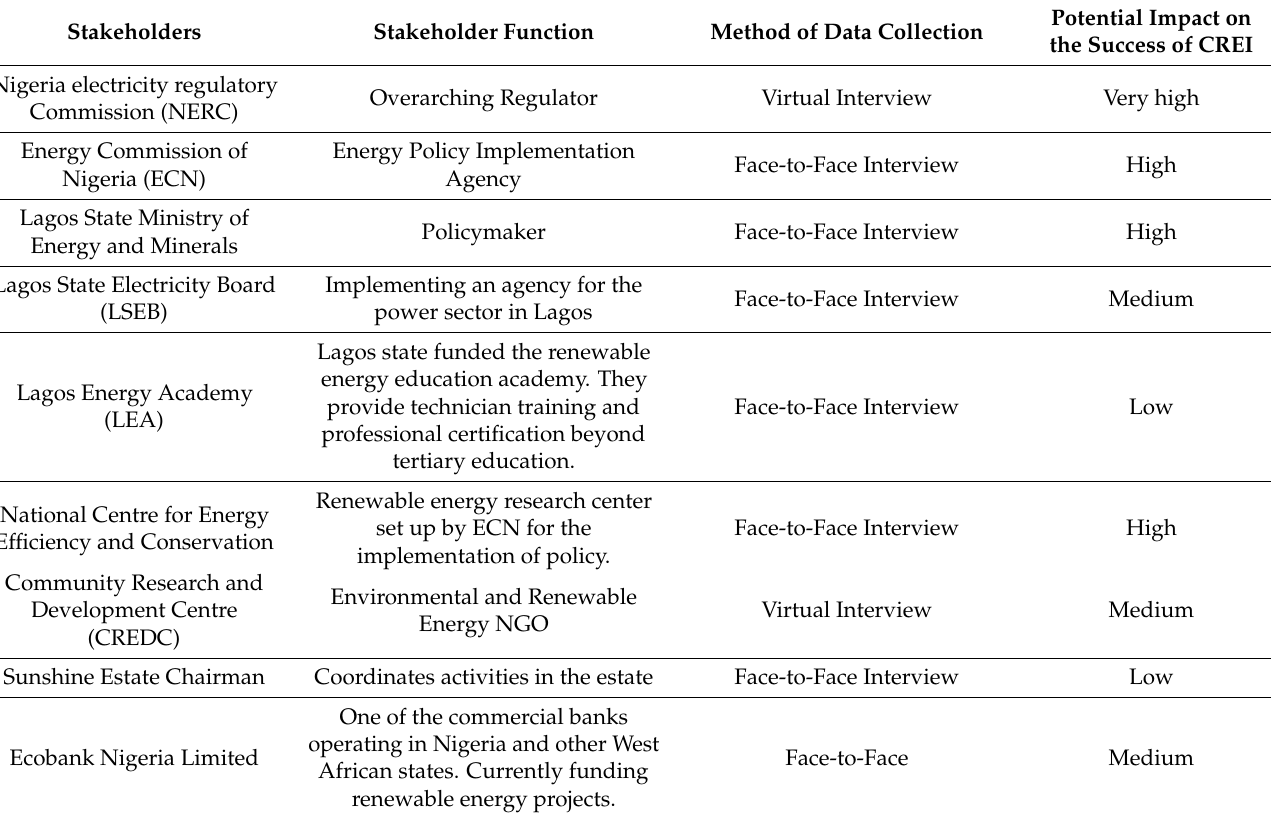
Table 1. Overview of stakeholders